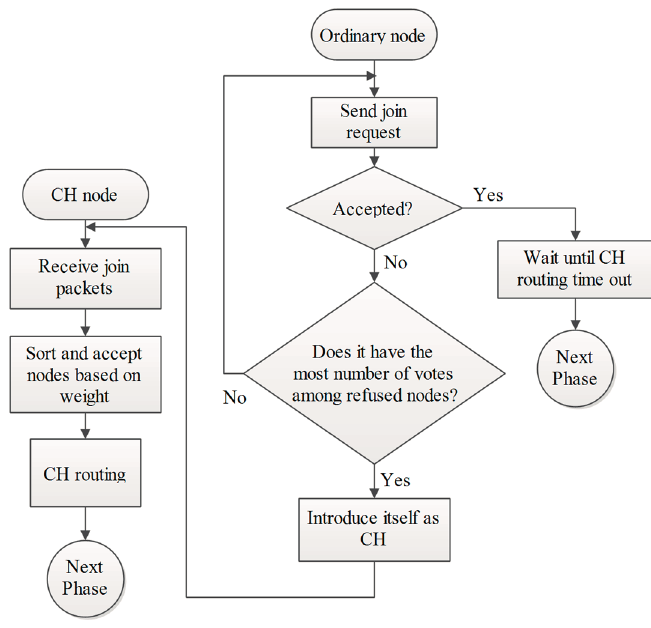
Figure 8. Phase C and